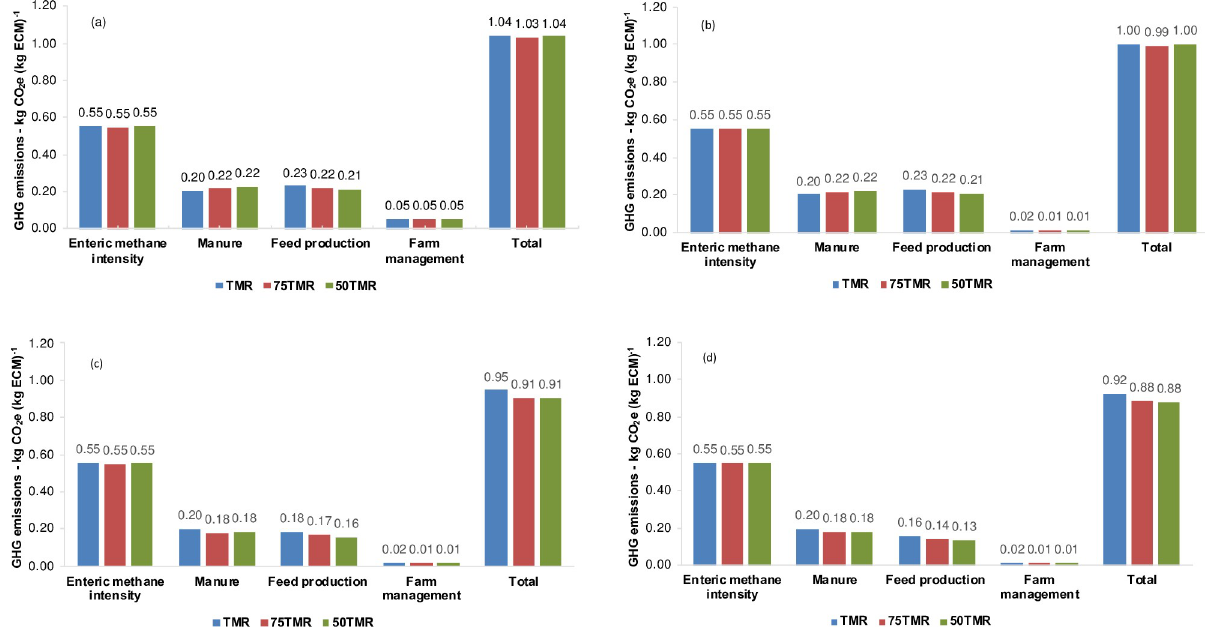
Fig 2. Overall greenhouse gas emissions in dairy cattle systems under various scenarios. TMR = ad libitum TMR intake, 75TMR = 75% of ad libitum TMR intake with access to pasture, 50TMR = 50% of ad libitum TMR intake with access to pasture. (a) N 2 O emission factors for urine and dung from IPCC [38], feed production emission factors from Table 3 without accounting for sequestered CO 2 -C from perennial pasture, production of electricity = 0.73 kg CO 2 e kWh -1 [41]. (b) N 2 O emission factors for urine and dung from IPCC [38], feed production emission factors from Table 3 without accounting for sequestered